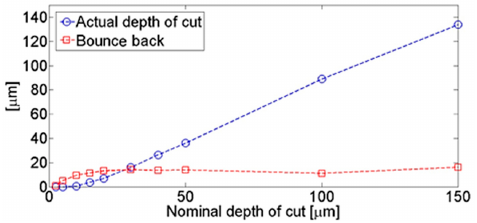
Figure 22. Bounce back and actual cutting depth for a fibre orientation of 0°, a rake angle of − 10°, and a cutting speed of 12 mm/min (Experiment 1). and a cutting speed of 12 mm/min (Experiment 1).